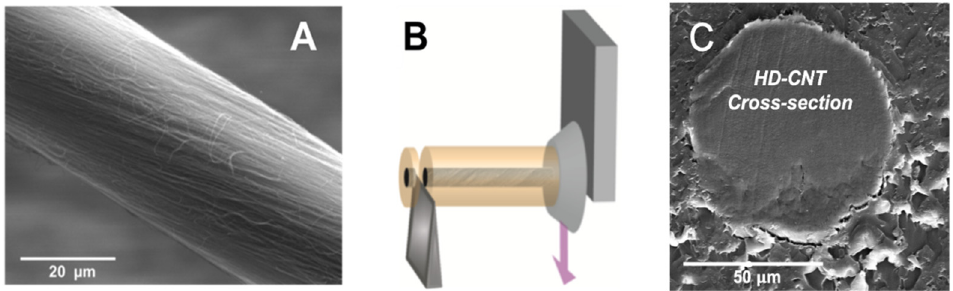
Figure 1. Characterization and fabrication of HD-CNT. ( A ) SEM image of a CNT fiber. ( B ) CNT fiber encapsulation within a polymer and subsequent sectioning. ( C ) SEM image of a cross-section of the resulting HD-CNT.